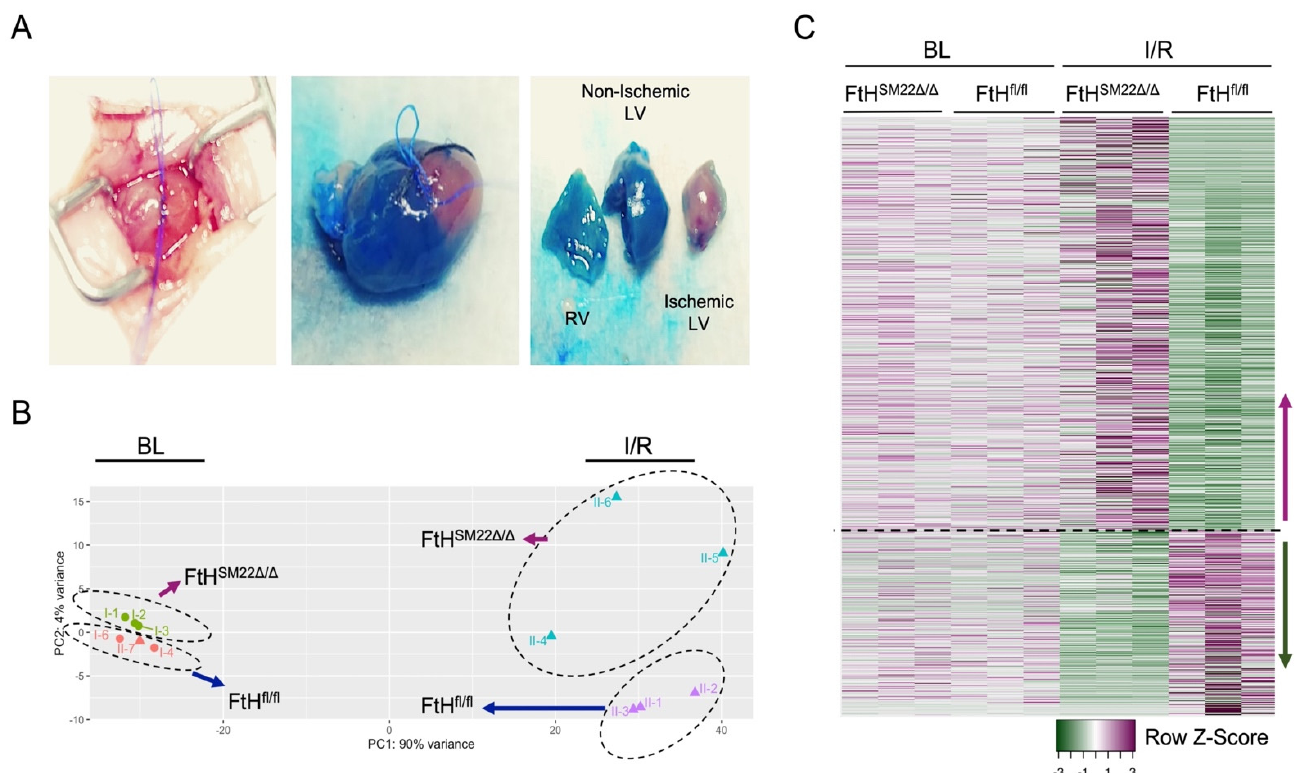
Figure 6. Alteration of gene expression profile in FtH fl/fl and FtH SM22 Δ / Δ hearts following IR. ( A ) Demonstrative image illustrating dissection of the ischemic region at 3 h post reperfusion. ( B ) Principal component analysis plot of samples obtained under BL and IR conditions demonstrating clusters of samples based on their gene expression profile. ( C ) RNA isolated from the left ventricle and ischemic regions of FtH fl/fl and FtH SM22 Δ / Δ hearts was subjected to bulk RNA-sequencing analysis. The image represents hierarchical clustering of genes that are significantly altered (fold change > 2, p < 0.05) between isolated myocardium from different genotypes at 3 h post reperfusion. Heatmap displays z-transformed expression values. n = 3/group.